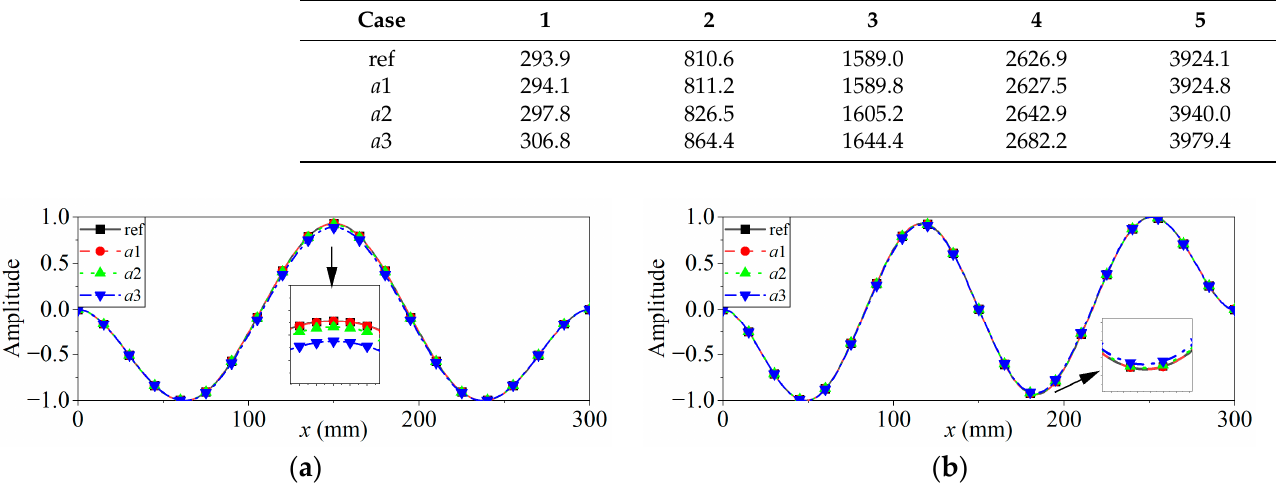
Figure 4. The mode shapes under different static loads: ( a ) the 3rd mode shape; ( b ) the 4th mode shape.